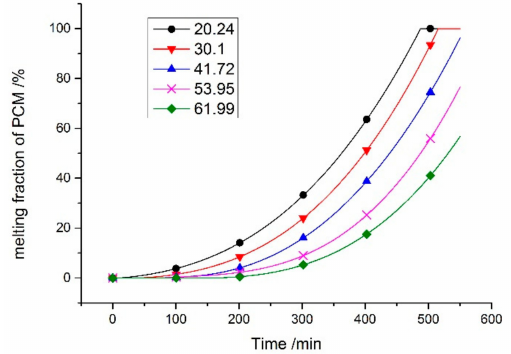
Figure 7. Curve of melting fraction of phase change layer with time under di ff erent PCMs.